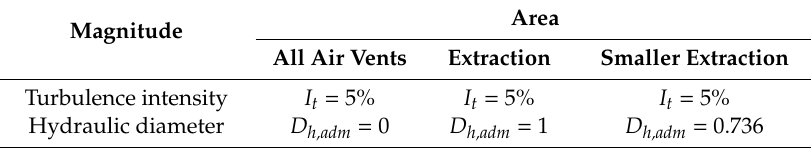
Table 2. Boundary conditions imposed in the air vent and extraction